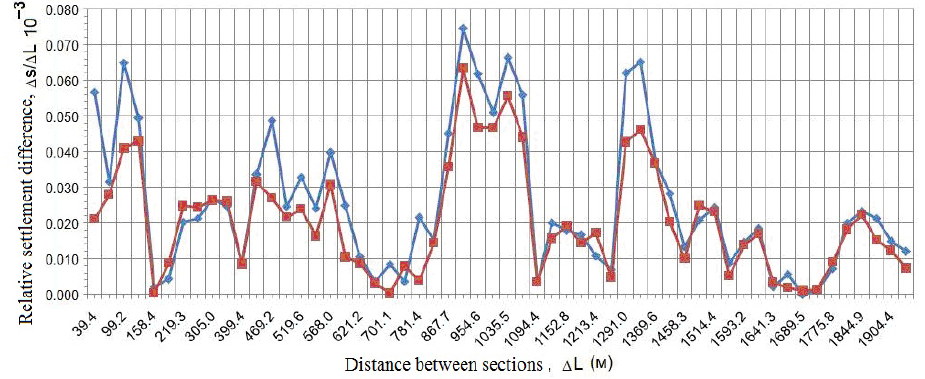
Figure 5. Graphs of changing the relative subsidence difference by the lines AA (cid:48) (red) and BB (cid:48) (blue): (cid:49)L is the distance between the centers of the first and the each of the following 56